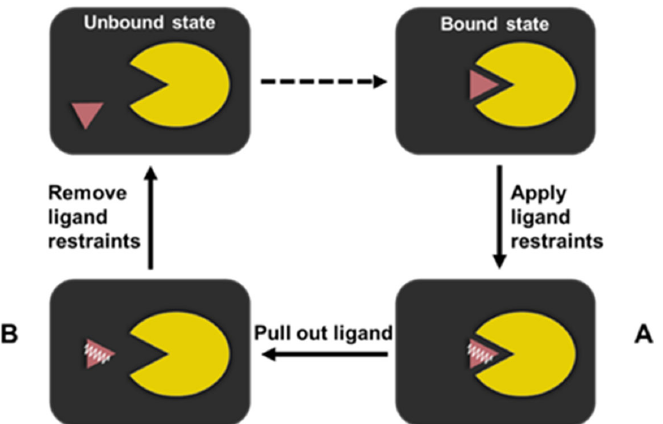
Figure 6. The RMSF-based PMF protocol based on the thermodynamic cycle adopted by the ILPR G4-ligand system. The ILPR G4 and its binding ligand are represented by the yellow Pac-man and purple triangle, respectively. The harmonic restraints applied to the ligand are indicated by a white spring.